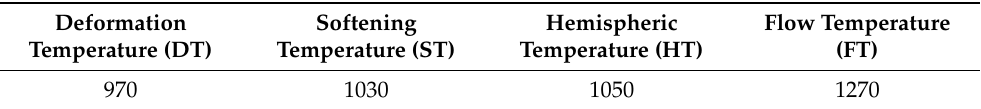
Table 2. Test and analysis results of the ash fusibility of fly ash (°C).